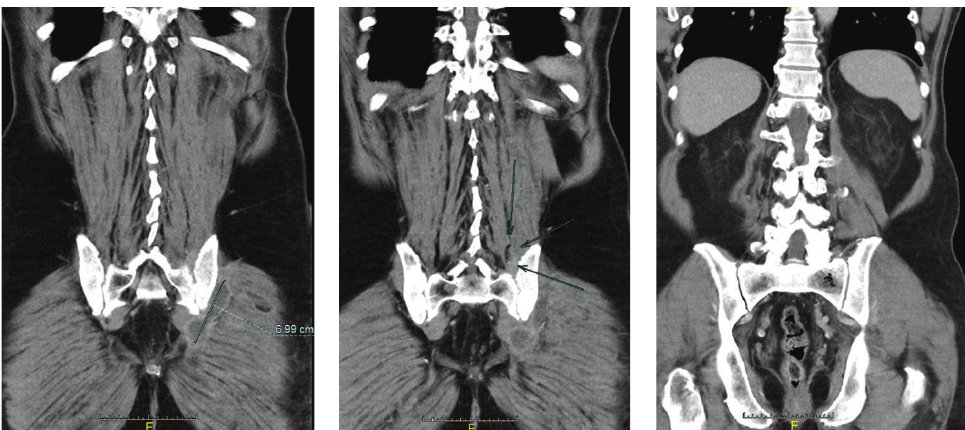
Figure 3: CT scan with multiple free air bubbles in the massa lateralis of the sacrum as well as edema of the iliacus and lumbricales muscles of the left side.